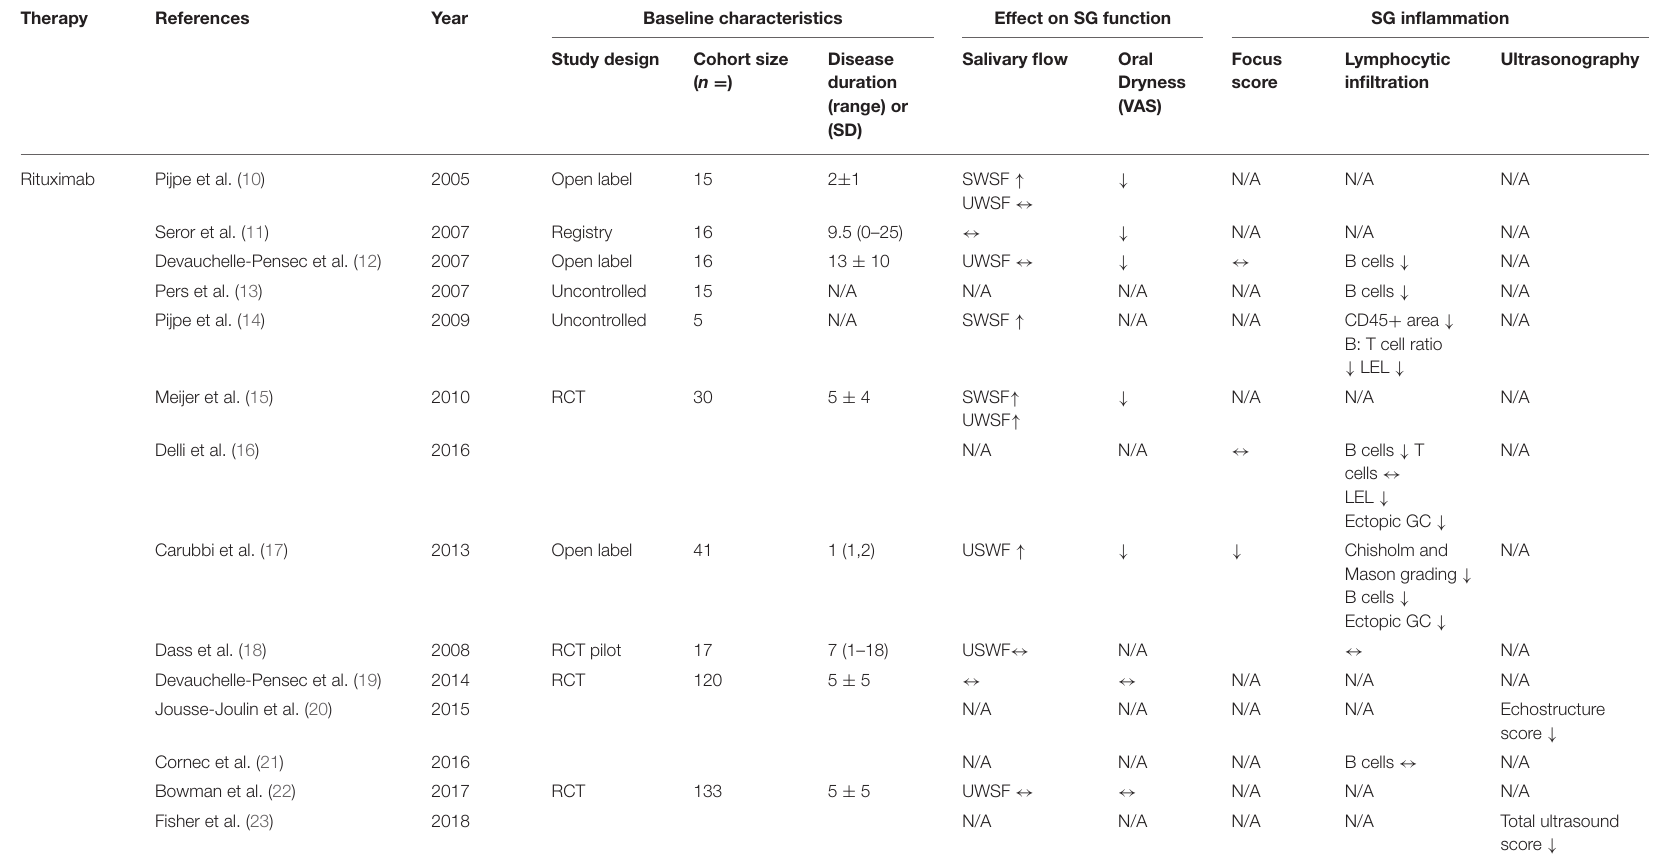
TABLE 1 | Clinical trials which have investigated the effects of biological therapies in pSS.